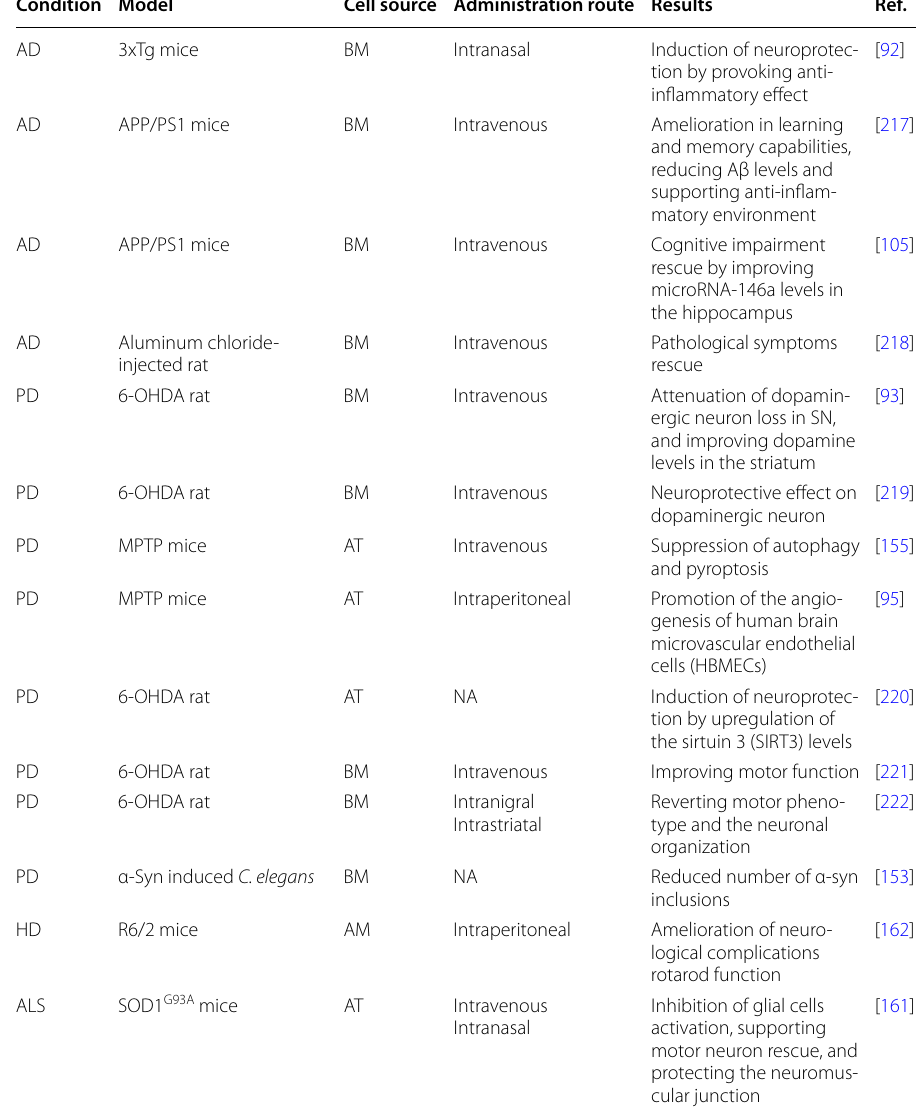
Table 3 MSC-derived secretome (e.g., exosome) therapy in preclinical models of common neurodegenerative